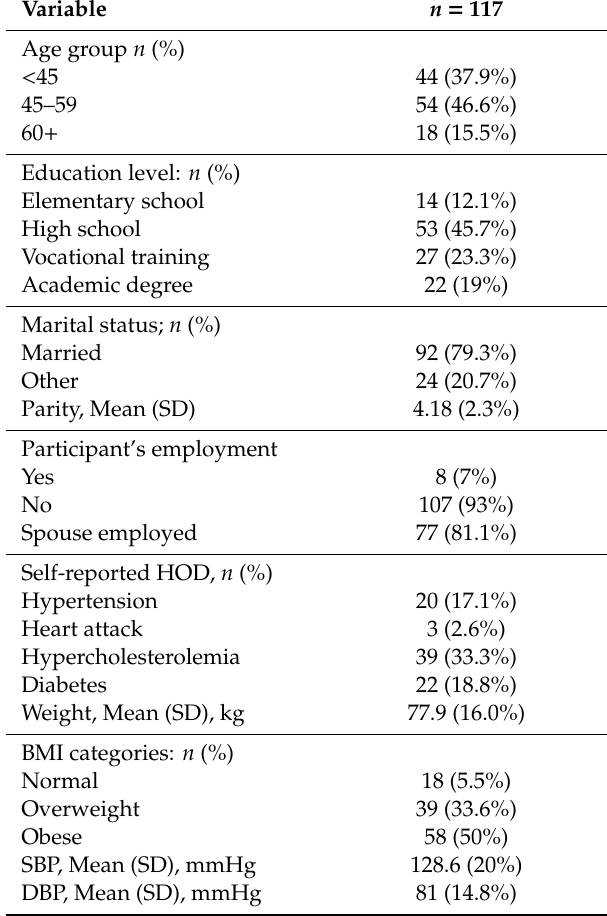
Table3. Baselinesociodemographic andhealthcharacteristics ofparticipants inthedissemination